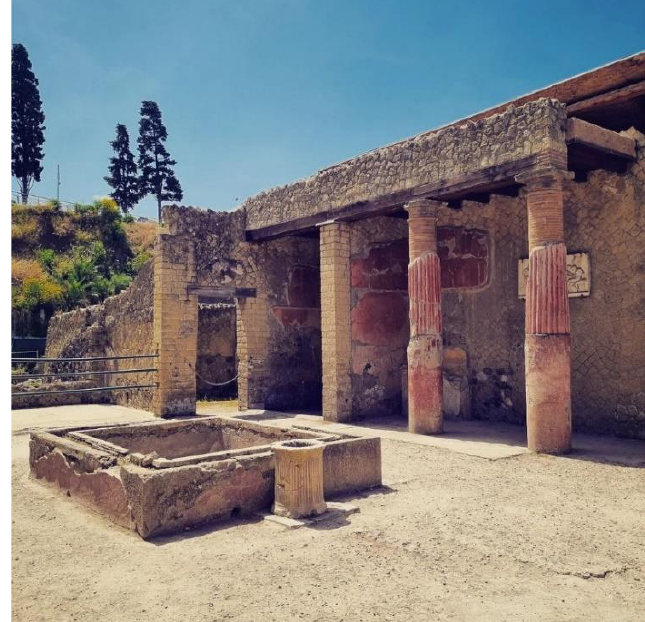
Figure 4. View of the domus of relief of Telephus [31].